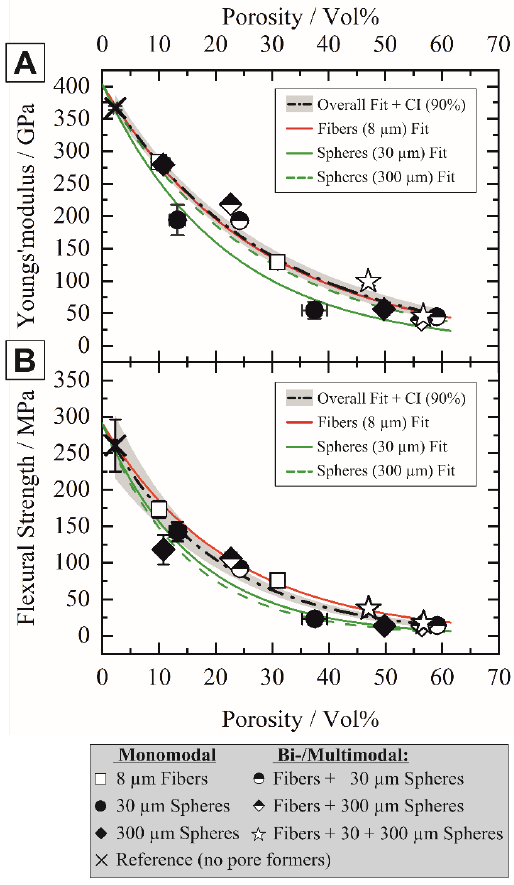
Figure 9. Influence of the amount and shape of the sacrificial templates on the mechanical properties of Al 2 O 3 ceramics with multimodal porosity: Young’s modulus ( A ) and flexural strength ( B ) in dependence of the total sample porosity fitted by the exponential model of Equation (1).